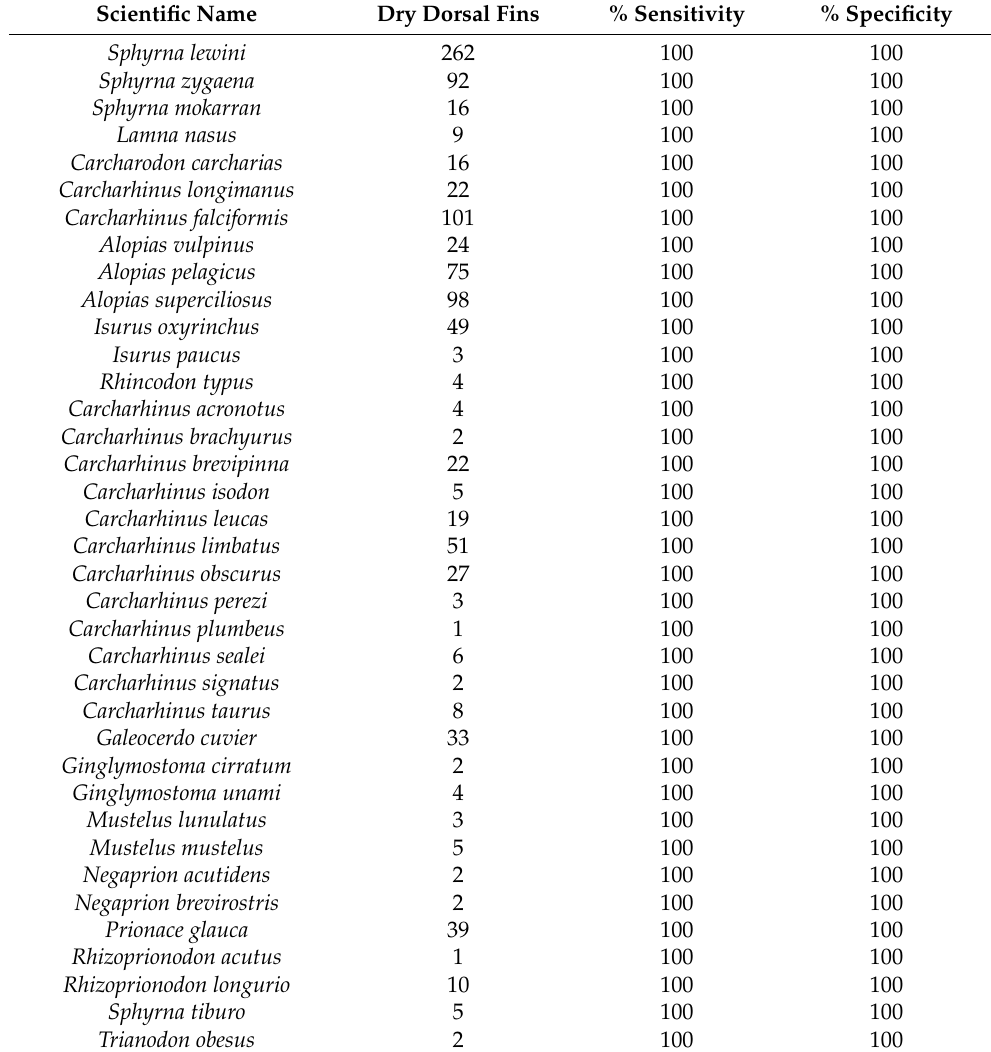
Table 1. Sensitivity and specificity percentage of each of the dry dorsal fin species of sharks using the non-linear composite